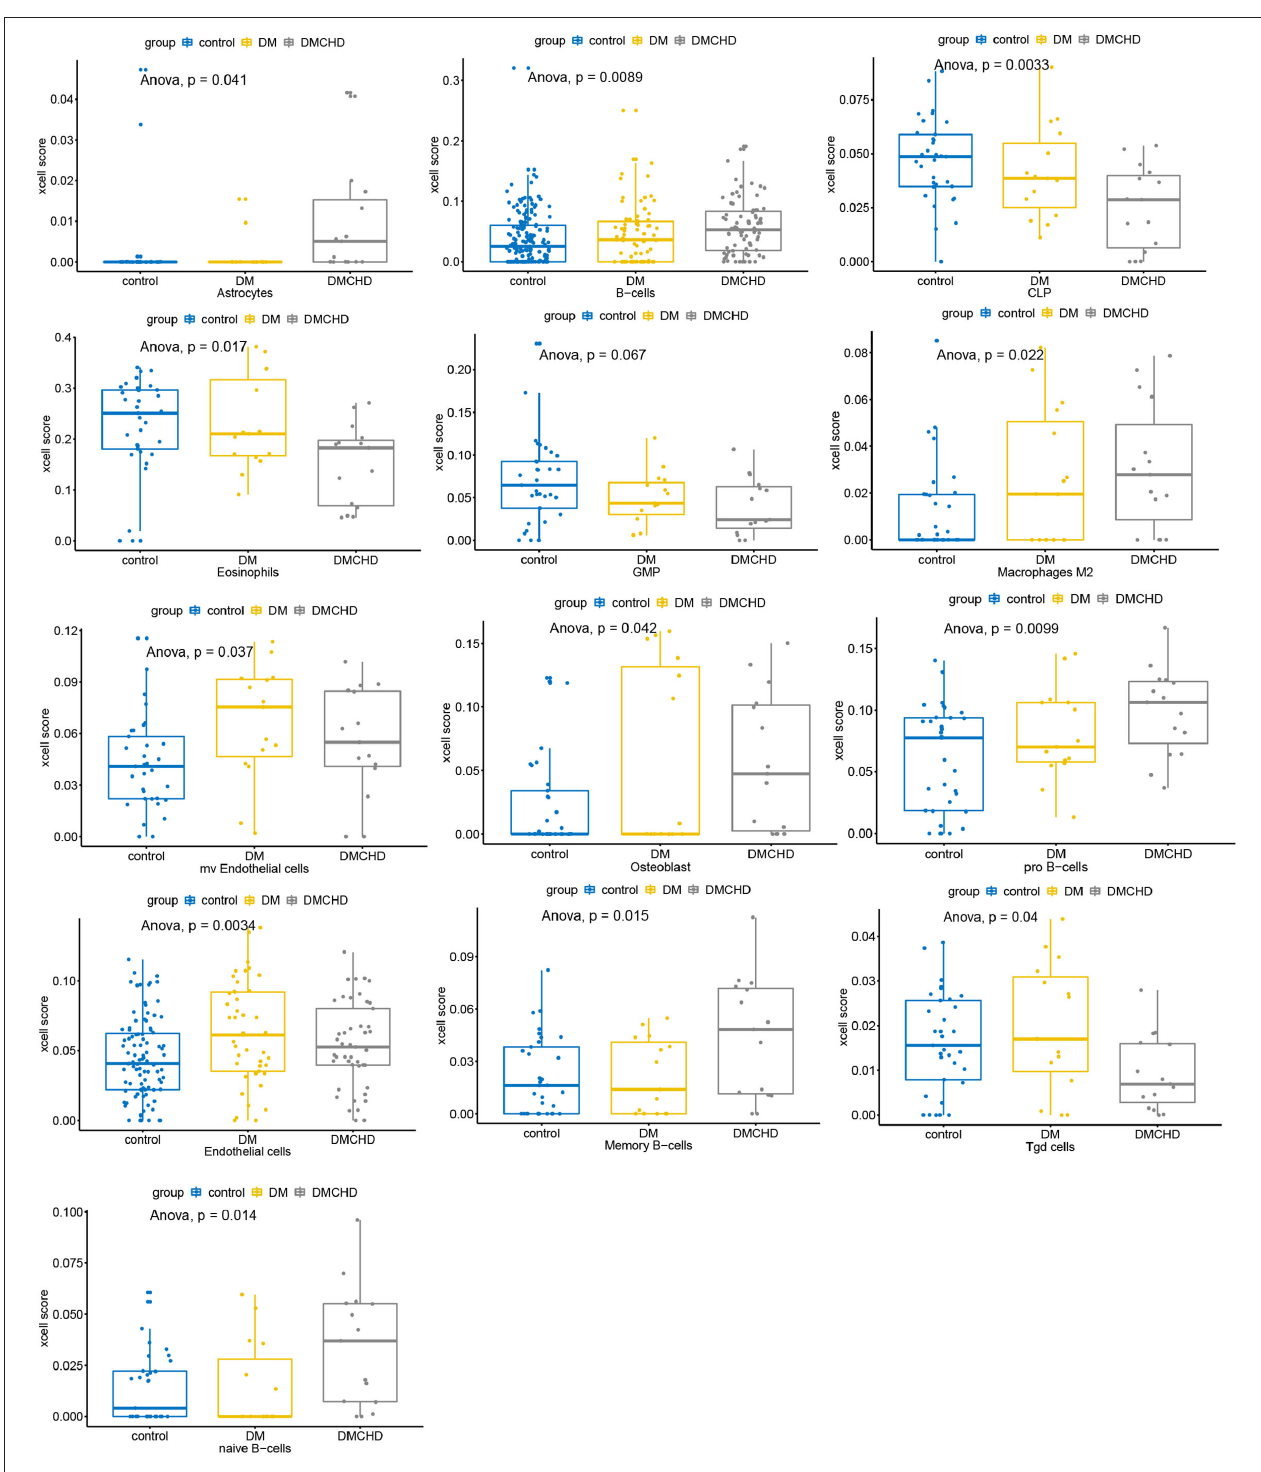
FIGURE 6 | Various cell types vary in control, DM and DMCHD. DM, diabetes mellitus, DMCHD, diabetes mellitus and coronary heart disease, CLP, common lymphoid progenitor cell; GMP, granulocyte macrophage progenitor; Tgd cells, gamma delta T cells; mv endothelial cells, mitral valve endothelial cells. Anova, analysis of